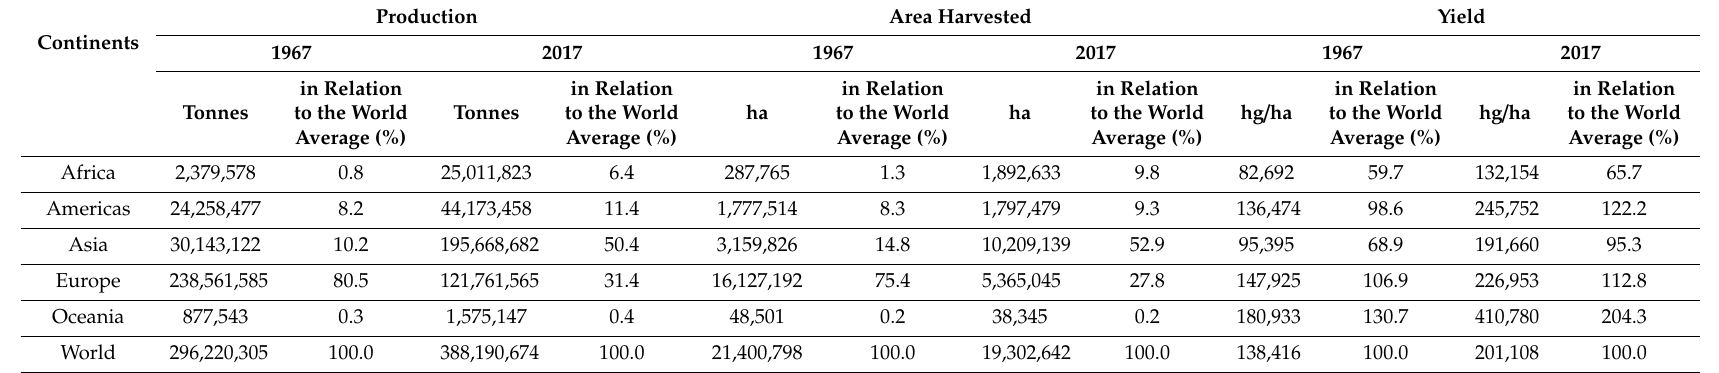
Table 2. Production (in tonnes), area harvested (in ha) and potato yield (in hg / ha) on continents and their percentage share in relation to the world average in 1967 and 2017